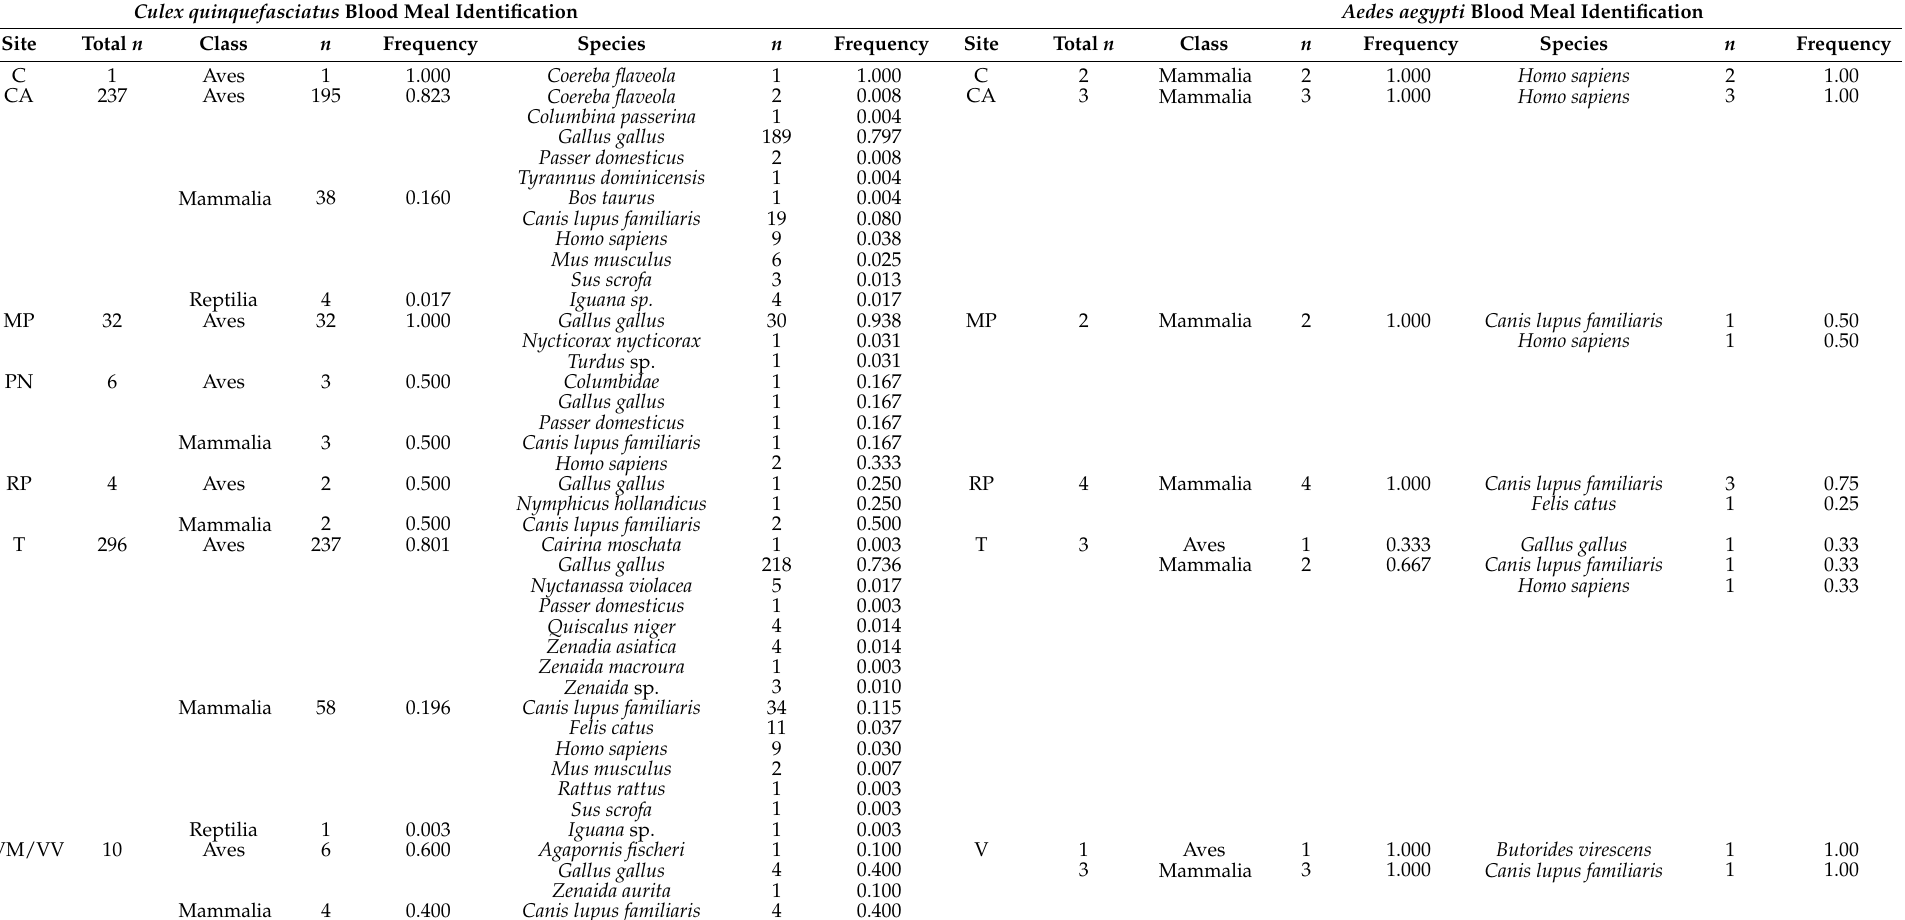
Table 4. Molecular blood meal identifications separated by trapping site. Identifications are presented for class and species. The number of times that species was detected in an individual mosquito ( n ) and frequency of identification are presented for two mosquito species collected in the San Juan Metropolitan Area, Puerto Rico. Culex quinquefasciatus Blood Meal